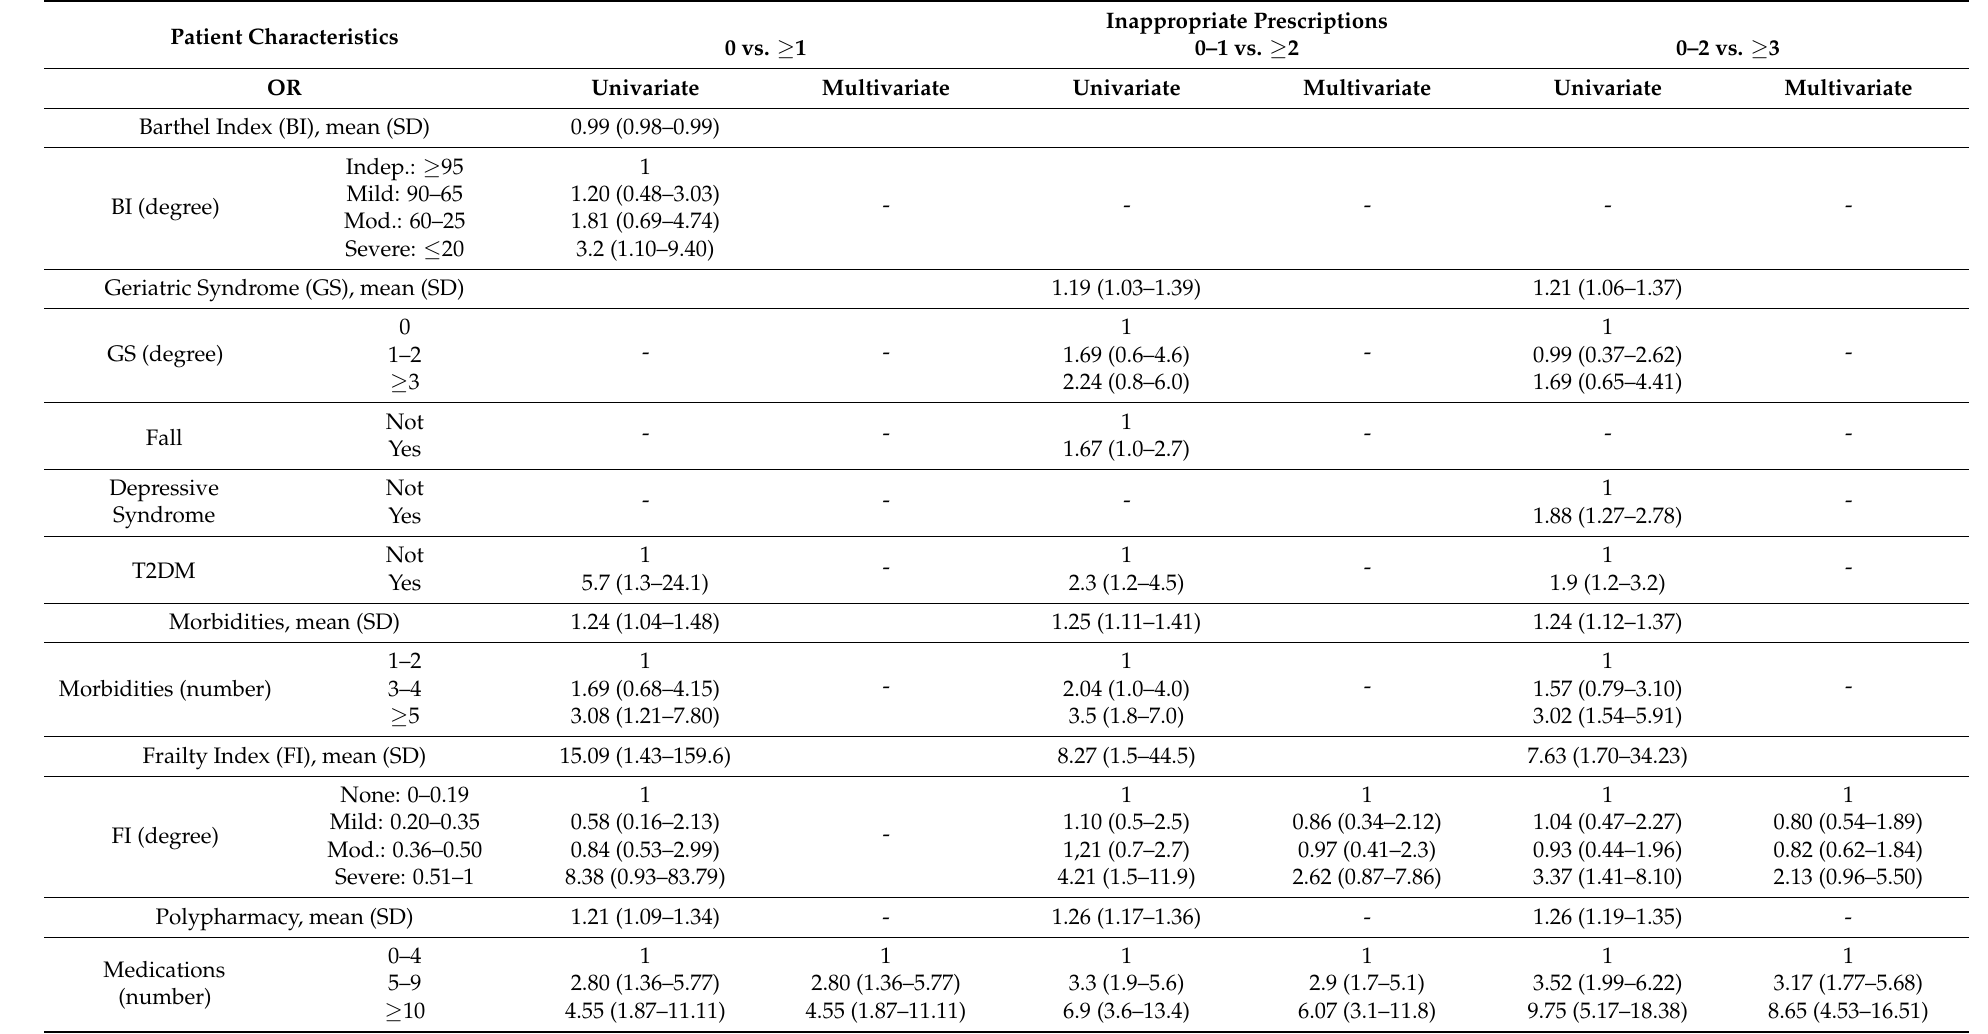
Table 6. Univariate and multivariate